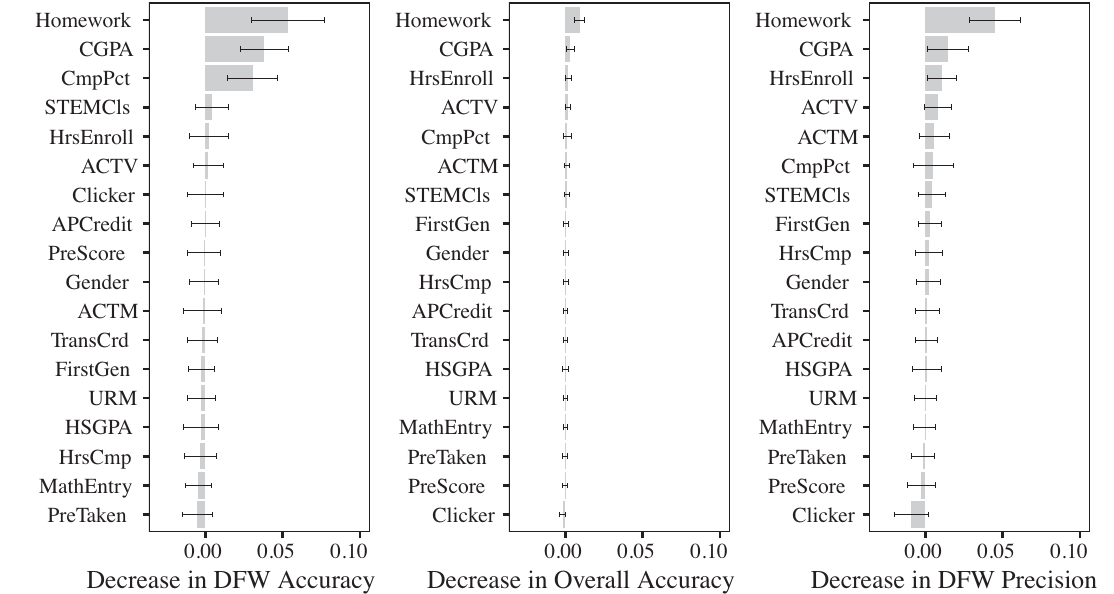
FIG. 1. Variable importance of the optimized model predicting DFW for sample 2 using institutional data and data available in class at the end of week 2. Error bars are one standard deviation in length.